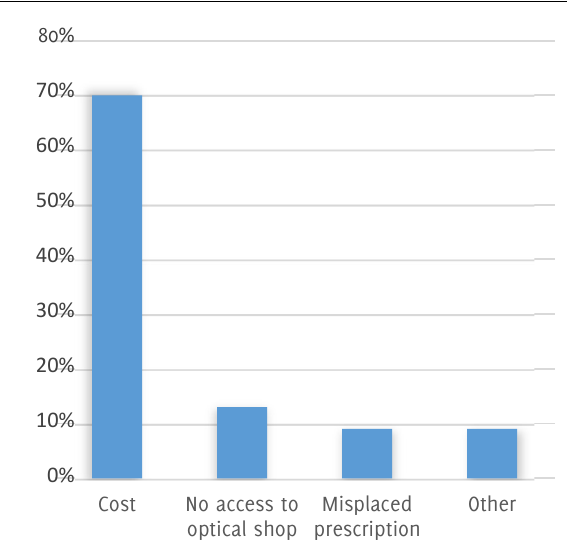
Figure 1 . Reasons Cited by Patients for not Obtaining Glasses Elsewhere if Recycle Vision Clinic Was not an